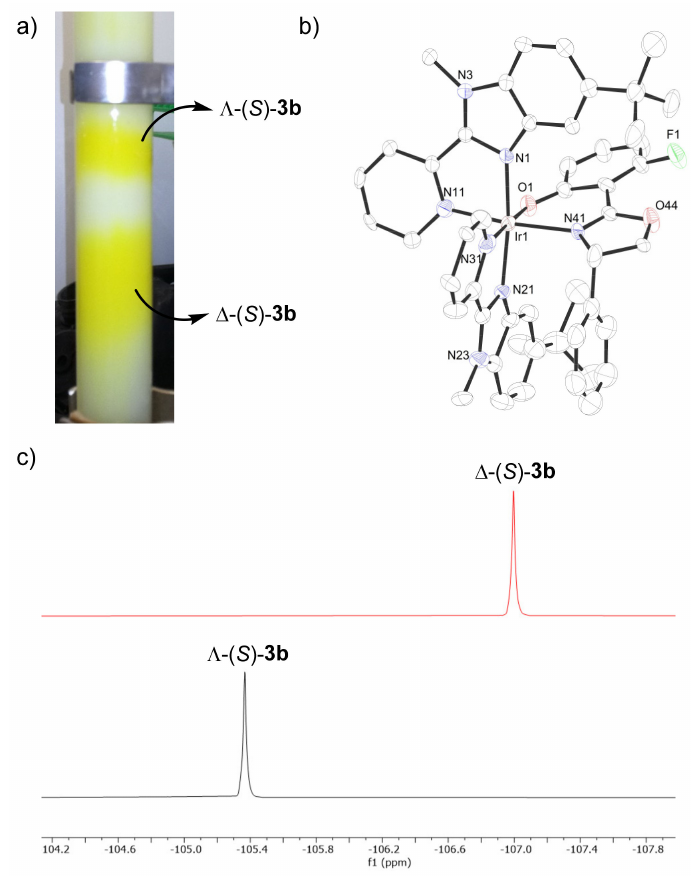
Figure 2. Auxiliary complexes of the iridium benzimidazole system. a ) Chromatographic separation of Λ -( S )- 3b and ∆ -( S )- 3b during silica gel column chromatography ( n -pentane/EtOAc). b ) Single- crystal X-ray structure of Λ -( S )- 3b . ORTEP drawing with 30% probability thermal ellipsoids. Solvent molecules are omitted for clarity. c ) 19 F-NMR spectra of the individual diastereomers Λ -( S )- 3b and ∆ -( S )- 3b .